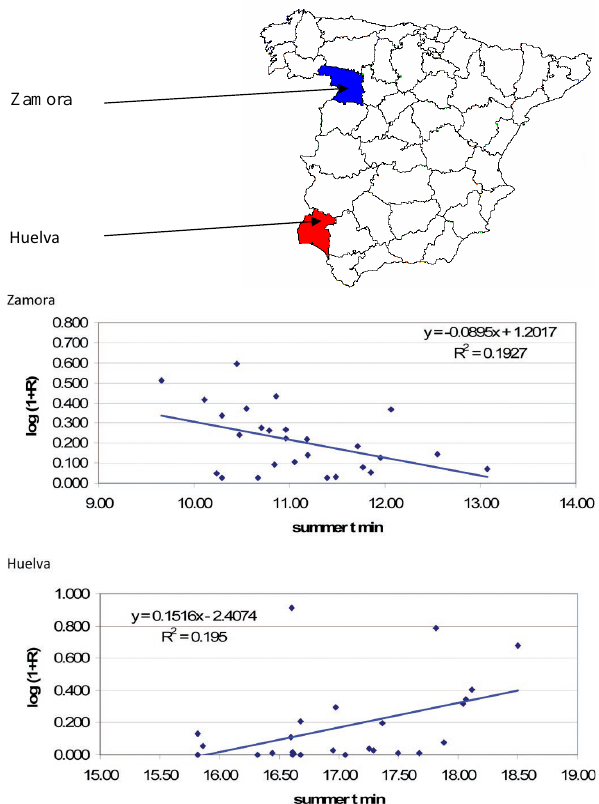
Fig. 3. Correlations estimated between hail damage and minimum summer temperature for Huelva and Zamora. Graphs show mini- mum summer temperature at the x-axis (summer t min) and trans- formed hail damage index (log(1+ R )) at the